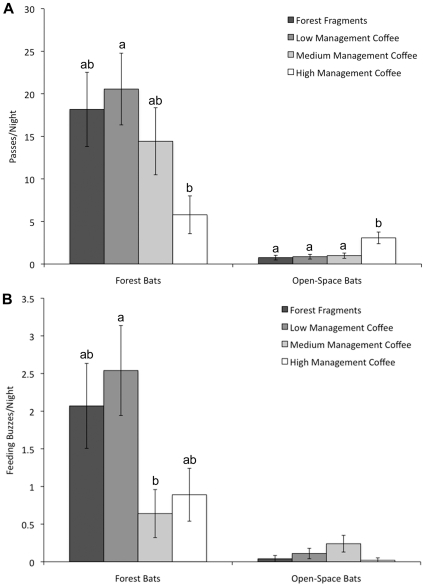
Relative activity of aerial insectivorous bats across land-use types.Mean±SE of passes per night (panel A) of forest and open-space bats; and feeding buzzes per night (panel B) of forest and open-space bats. Means are estimated marginal means (calculated using generalized linear models and incorporating significant covariates of cloud cover and elevation for pass rates of open-space bats). Means with different letters were significantly different (sequential Bonferroni, p<0.05).